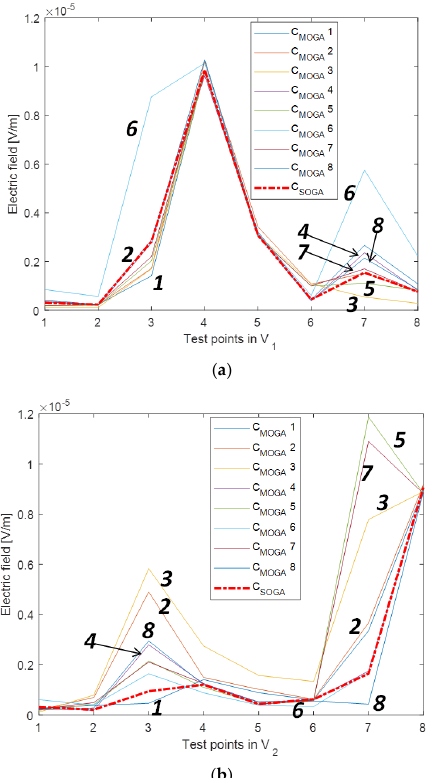
Figure 7. Magnitude of the electric filed in ( a ) the N 1 test points of volume V 1 and ( b ) the N 2 test points of volume V 2 , due to the optimal MOGA solutions C MOGA i in Table 1.